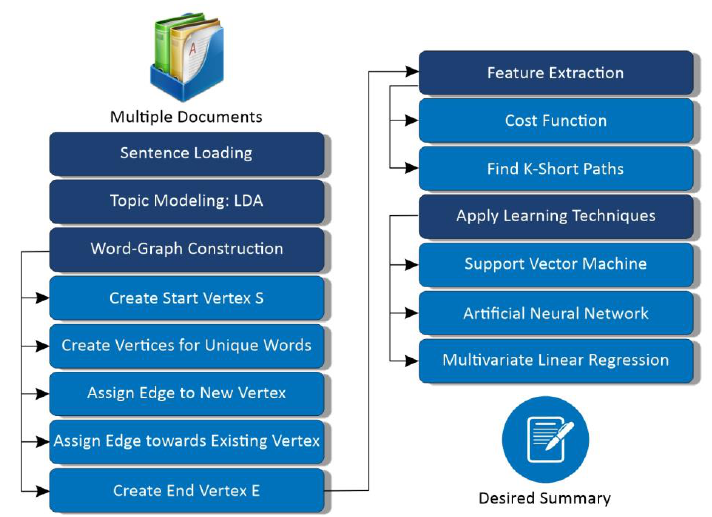
Figure 3. Architecture diagram of Grapharizer with ML